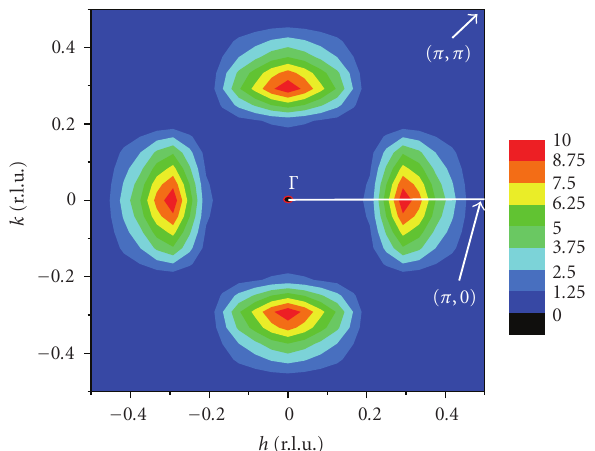
Figure 15: Qualitative picture of the di ff erence in the linewidths of the bond-stretching phonon in optimally-doped ( x = 0.15) and overdoped ( x = 0.3) La 2 − x Sr x CuO 4 as a function of wavevector in the ab-basal plane based on [30, 37]. The units are meV. The solid line indicates the [100] direction along which most of measurements were performed.